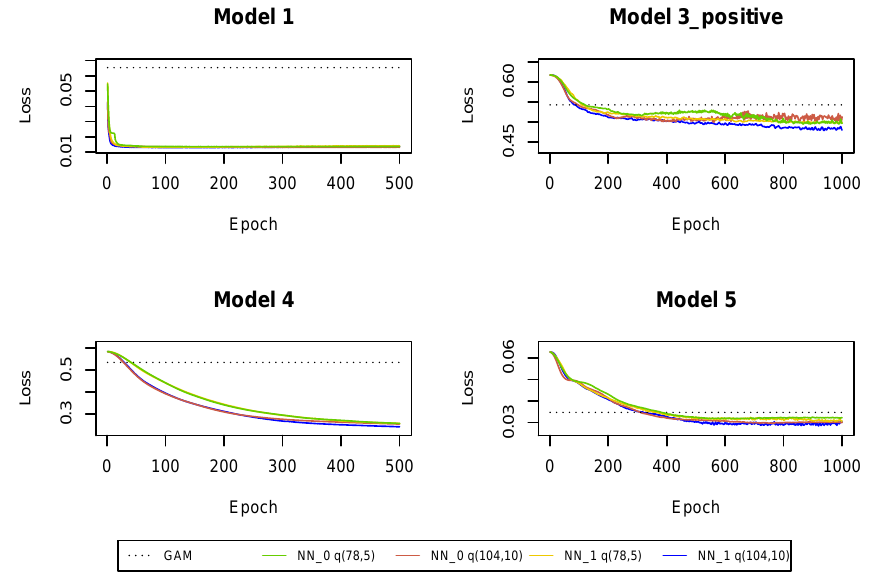
Figure A11. Cross-entropy and deviance loss functions on validation sets observed during the training of the neural networks in k =